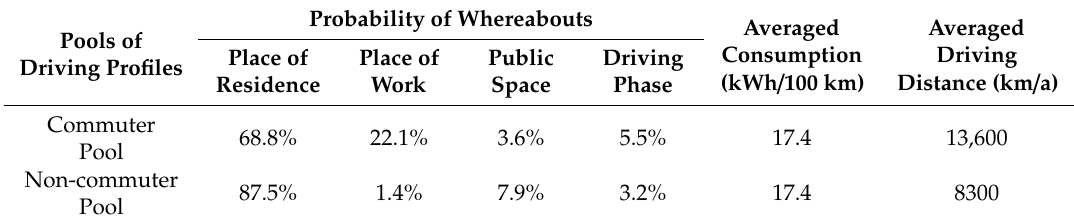
Table 2. Characteristics of user